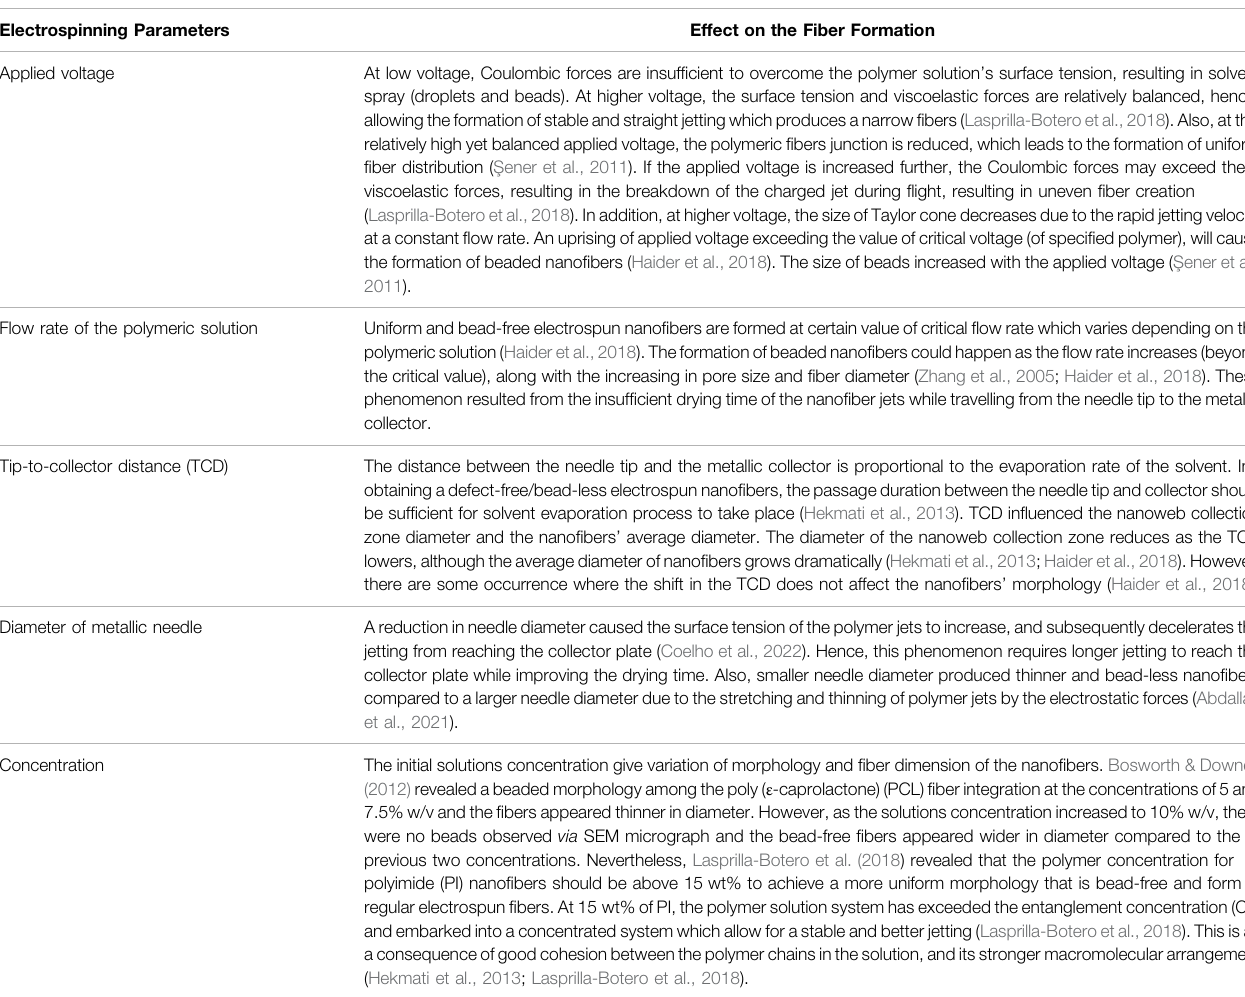
TABLE 2 | Summary on the effect of electrospinning parameter and the solution concentration towards the fi ber